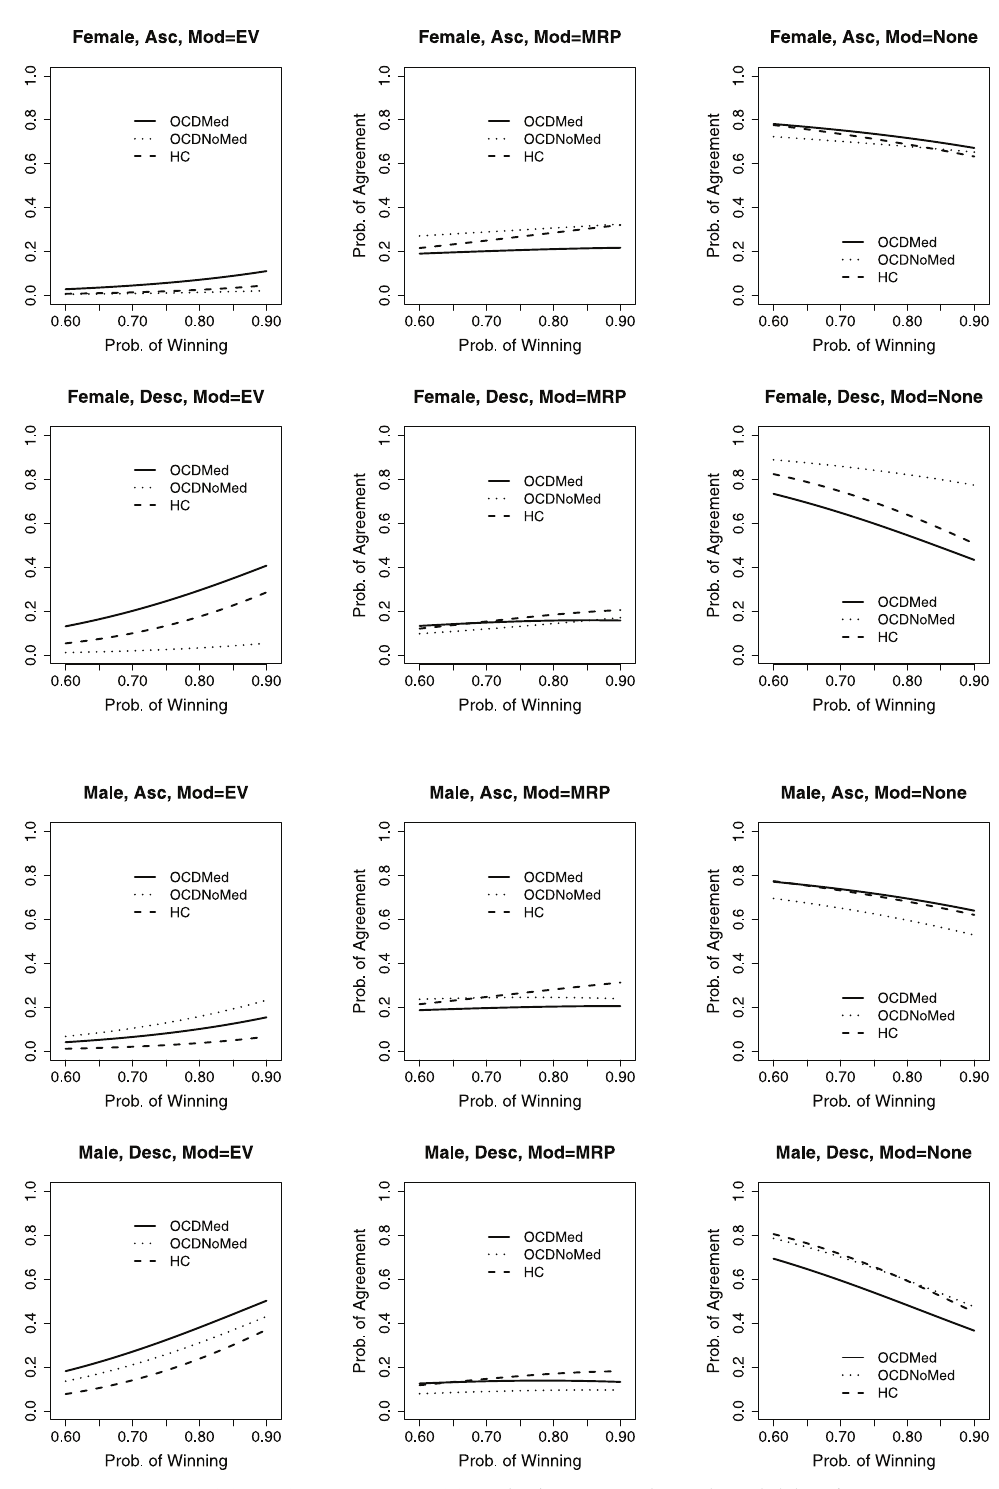
Fig 2. Estimated probabilities of agreement to models. Prob. of Winnning indicates the probability of winning as measured by the frequency of the chosen color. Prob. of Agreement indicates the probability of agreement to a model (EV, MRP, None). Each figure has Prob. of Agreement as function of Prob. of Winnning for medicated OCD patients, non medicated OCD patients, and for HCs.